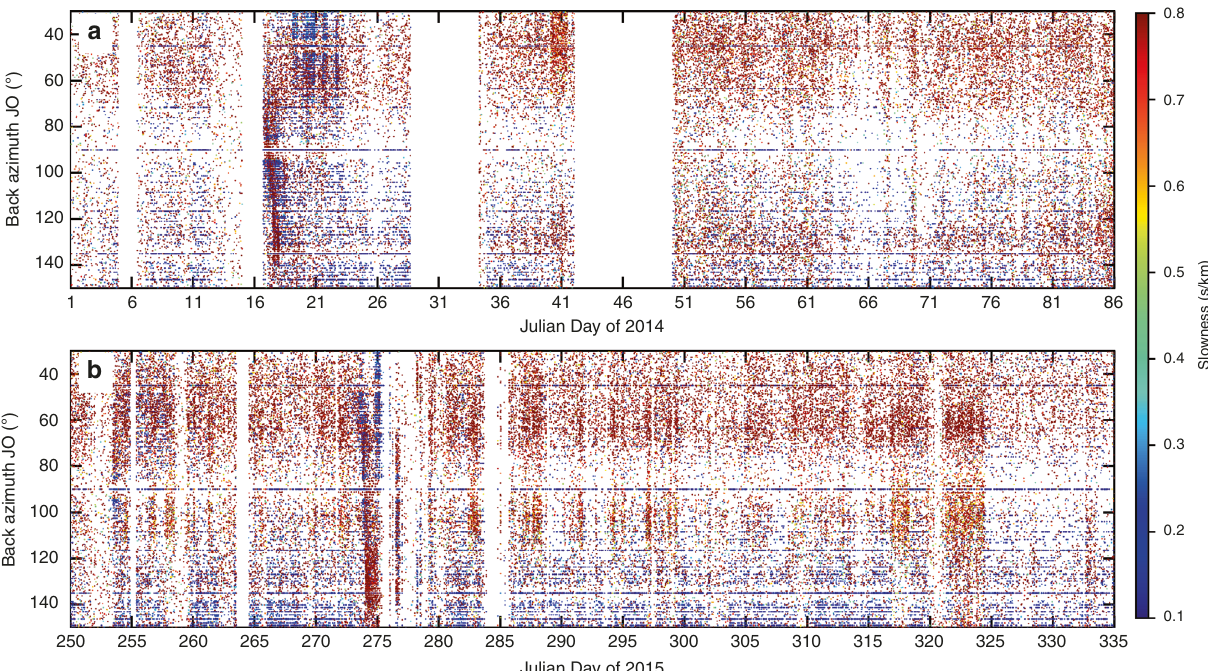
Fig. 5 Back azimuth and slowness changes reveal subglacial fl oods. The seismic data were fi ltered 1.4 – 3.2 Hz. a Flood from Western Skaftá cauldron in January 2014; b Flood from Eastern Skaftá cauldron in September 2015. In the total window of 170 days, the systematically migrating back azimuth signal can only be seen at times of known fl oods (from day 17 and 273, respectively) and not at any other times. This allows the development of a robust causal relationship between systematic changes in tremor back azimuth away from the cauldron, and propagating fl oods. The two known fl oods were later determined by hydrological observation and visual evidence of fl ooding. Note that JO array has data gaps from Julian day 275 and therefore only shows the beginning of Type 2